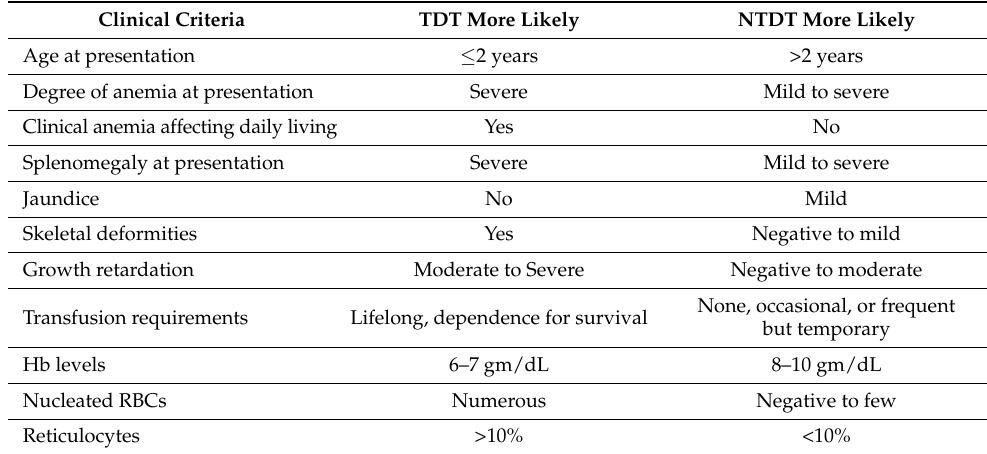
Table 1. Clinical criteria to differentiate TDT from NTDT.